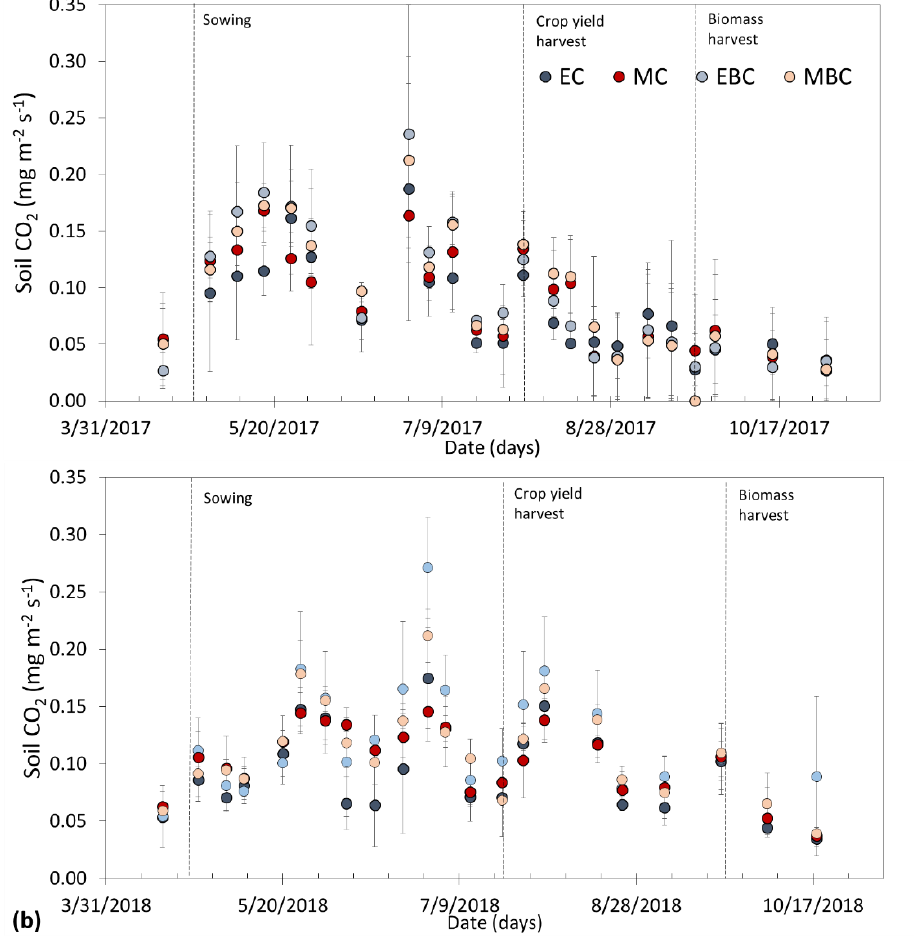
Figure 5. Soil CO 2 emission for the different treatments measured in ( a ) 2017 and in ( b ) 2018. n = 4; ± SD. EC represents empty control plots, MC represents the control plots with maize, EBC represents the empty plots with biochar, and MBC represents the plots with maize and biochar amendment.